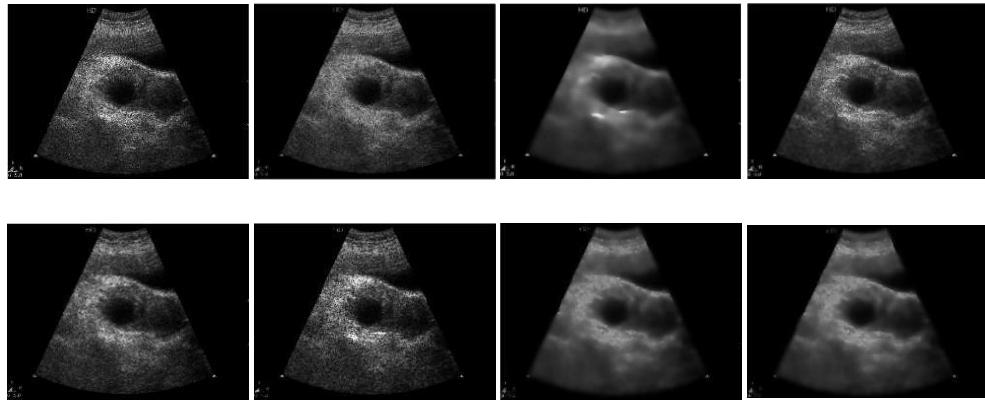
Fig. 4. The denoising effect with different methods on medical image. (a) noisy (b) BM3D (c) DnCNN (d) MSRResNet-GAN